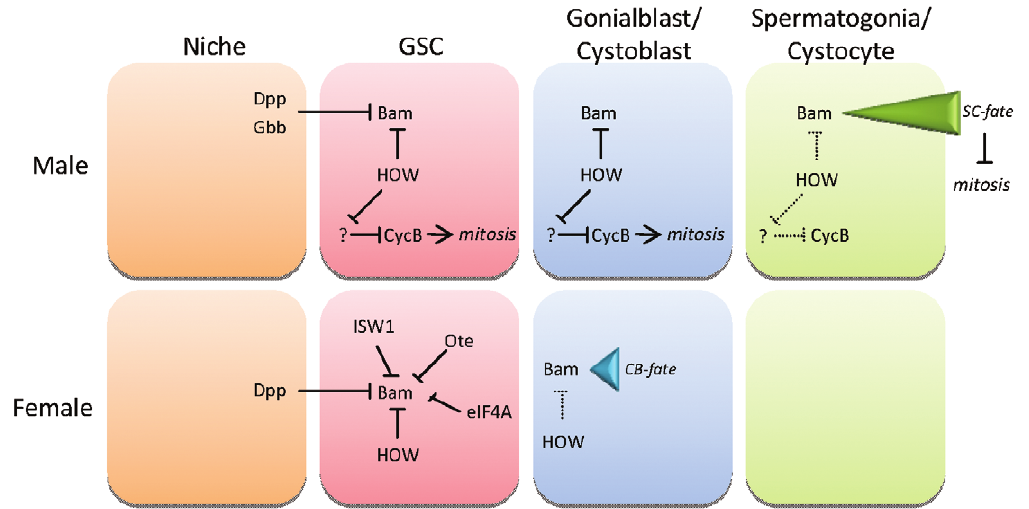
Figure 7. Model for HOW action in the male and female germline. In both sexes, Dpp signals from the niche or surrounding somatic cells transcriptionally repress bam in the GSC. In the male germline, HOW is expressed in the GSC, the gonialblast, and 2-cell spermatogonia, and is required for post-transcriptional repression of bam mRNA. At the 4-cell stage, levels of HOW are downregulated, coinciding with Bam protein first being detected. Bam accumulates during the spermatogonial mitotic period, and reaches a threshold value to cease mitotic amplification and initiate terminal differentiation into spermatocytes (SC). HOW also indirectly regulates CycB levels in the male germline to control the number of mitotic amplifications in which spermatogonial cells undertake prior to terminal differentiation. In the female germline, Bam is required during asymmetric stem cell division to specify the cystoblast (CB) cell fate. Levels of Bam required to initiate CB differentiation must be very low, as Bam is not observable by immunohistochemistry from the 2-cell stage. It is repressed in the GSC by many intrinsic factors including HOW. As levels of HOW are downregulated at the CB stage, Bam protein begins to accumulate, and can be visualised in 2-cell cystocytes. In the female, HOW does not play a role in regulating germ cell